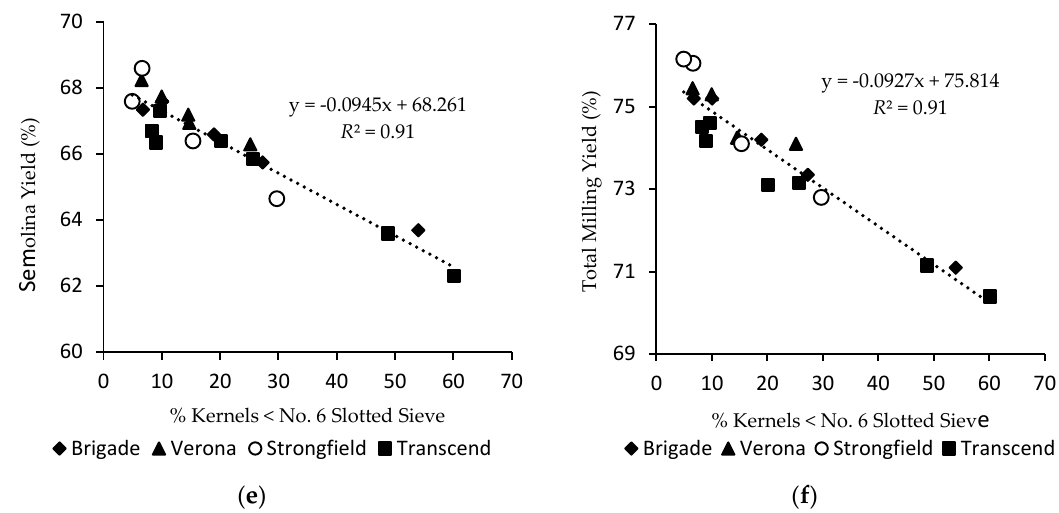
Figure 4. Relationships between semolina and total milling yields to test weight ( a , b ), thousand kernel weight ( c , d ) and proportion of kernels passing through slotted sieve no. 6 ( e , f ).